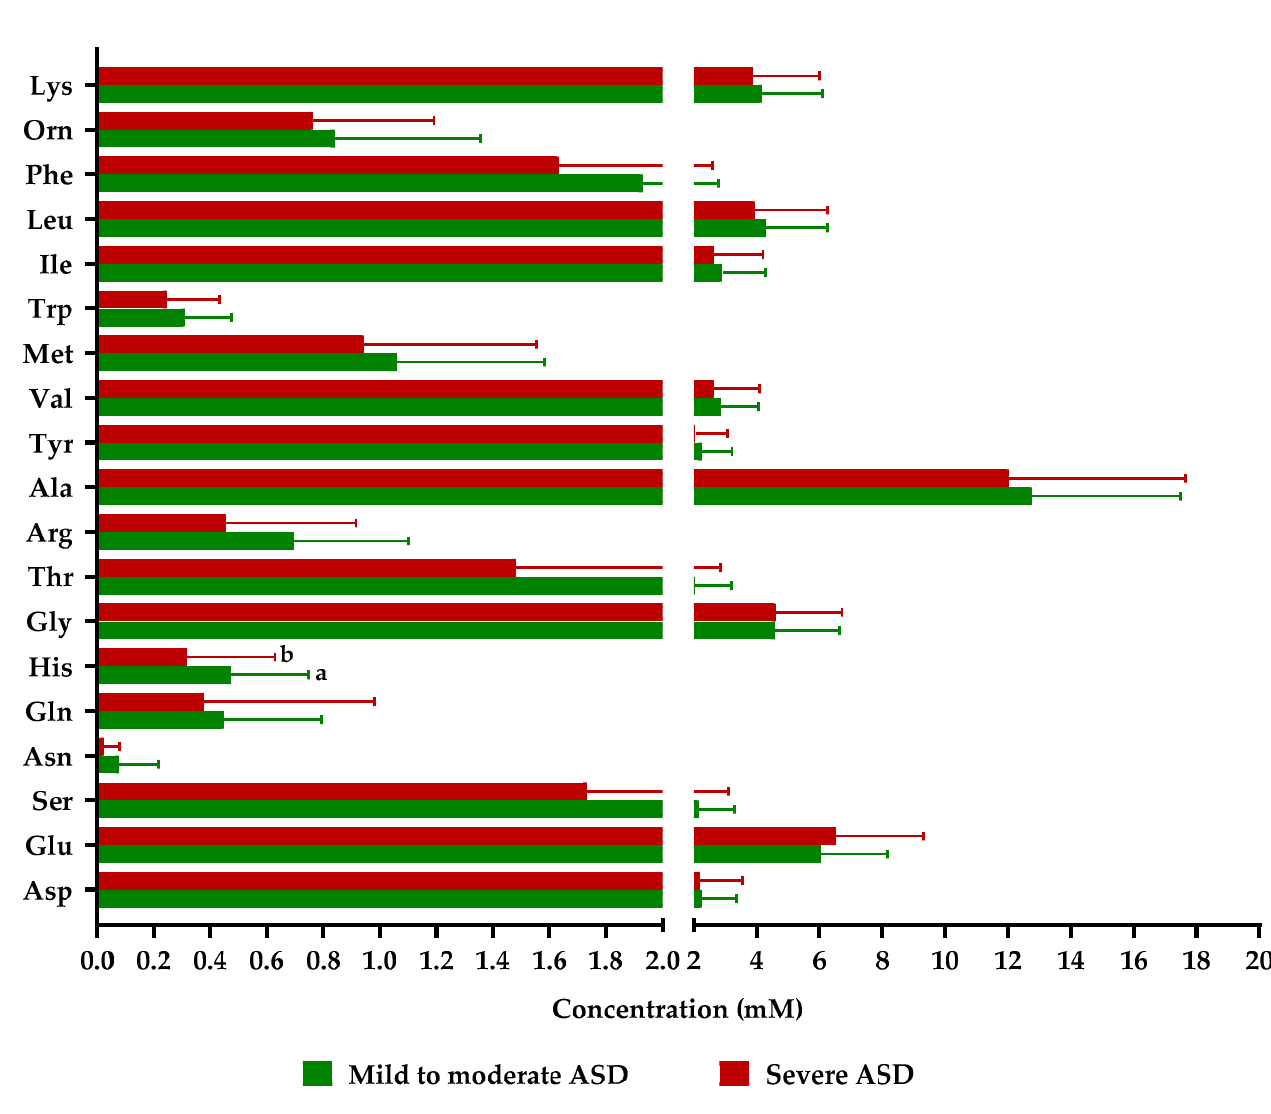
Figure 3. Fecal levels of amino acids in samples from autistic children (ASD), stratified by severity of the disease according to CARS score: mild to moderate (30–36) and severe (37–60). Asp: aspartate; Glu: glutamate; Ser: serine; Asn: asparagine; Gln: glutamine; His: histidine; Gly: glycine; Thr: threonine; Arg: arginine; Ala: alanine; Tyr: tyrosine; Val: valine; Met: methionine; Trp: tryptophan; Ile: Isoleucine; Leu: leucine: Phe: phenylalanine; Orn: Ornithine; Lys: lysine. Bars represent mean values and horizontal lines on the bars represent standard deviation. Different letters (a,b) indicate significant differences between groups of children for each amino acid ( p < 0.05).